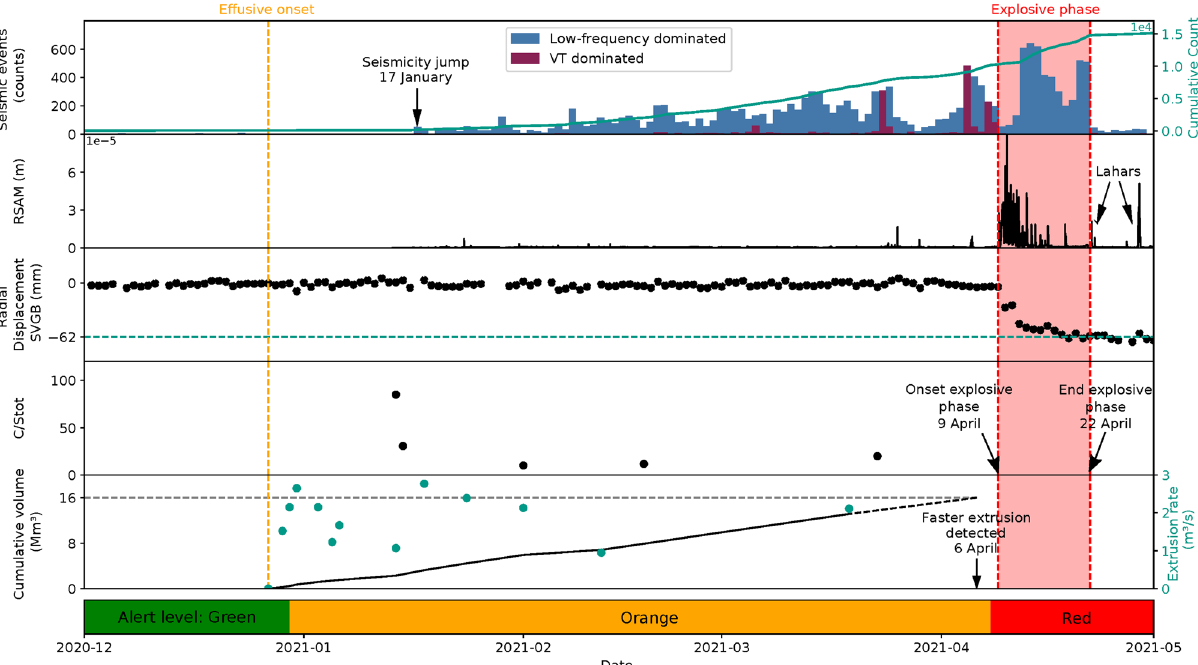
Fig. 2 Timeline of monitoring data for the 2020 – 2021 eruption at La Soufrière volcano, St. Vincent. Seismicity data: daily (bars) and cumulative (teal line) seismicity observed and a marker on the fi rst important increase (17 January). The bars in blue represent seismic events related to fl uid dynamics (low-frequency and dome emplacement) and the bars in dark red represent VT events. RSAM values: calculated with 1 min windows and no overlap; they correlate with VT swarms and explosive phase. Moreover, it shows evidence of lahar signals after the explosive phase. Deformation: radial extension from the vent observed at station SVGB, 9 km away from the crater, and associated uncertainties computed with GAMIT/GLOBK 48 . It shows a total movement of 62 mm towards the crater at the end of the explosive phase. C/S tot (CO 2 /H 2 S) concentration ratios (ppm) in the plume from MultiGAS measurements: First two data points evidence only H 2 S content, the remaining are a combination of H 2 S and SO 2 . The arrow shows the onset of explosive activity. Dome extrusion data: cumulative volume extruded in black line with an extrapolation until 6 April, extrusion rate in teal dots; the arrow marks the onset of rapid dome in fl ation as observed by a remote camera. The lowest bar shows the corresponding alert level for each day. In addition, vertical dashed lines show the onset of the effusive phase (orange) and the red area corresponds to the explosive phase.